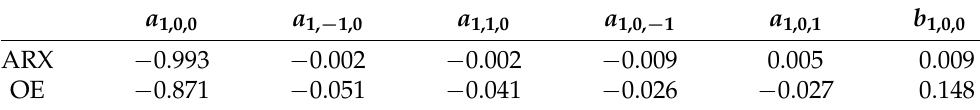
Table 3. Estimated model coefficients in single track case. Note, for brevity the same denotation of the parameters corresponding to shifted output values is used for both, ARX and OE